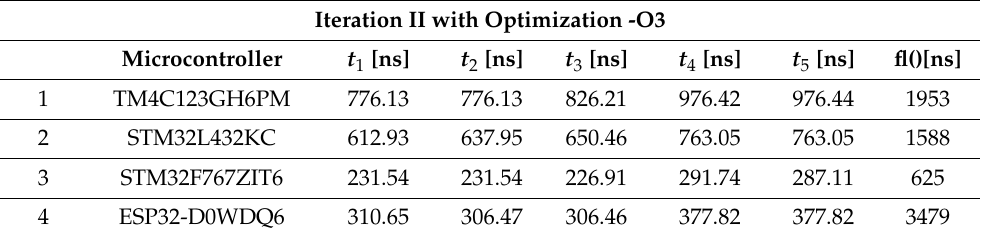
Table 3. Average function calculation times of InvCbrt(x) and fl() = 1.f/cbrtf() for Iteration II.